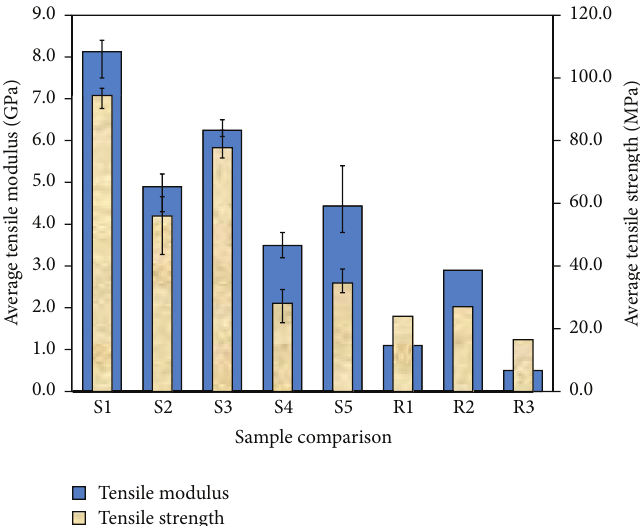
Figure 13: Tensile modulus and tensile strength of kenaf